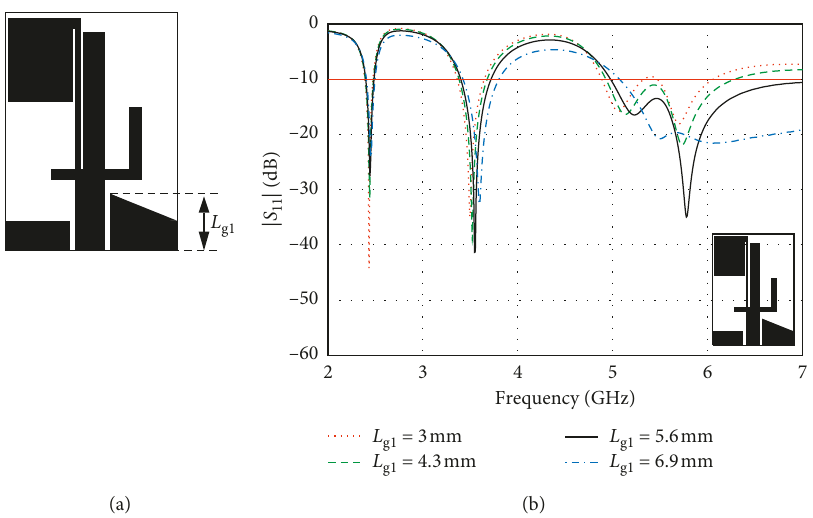
Figure 5: Simulated | S | at various stages of antenna evolution: the proposed antenna. 11